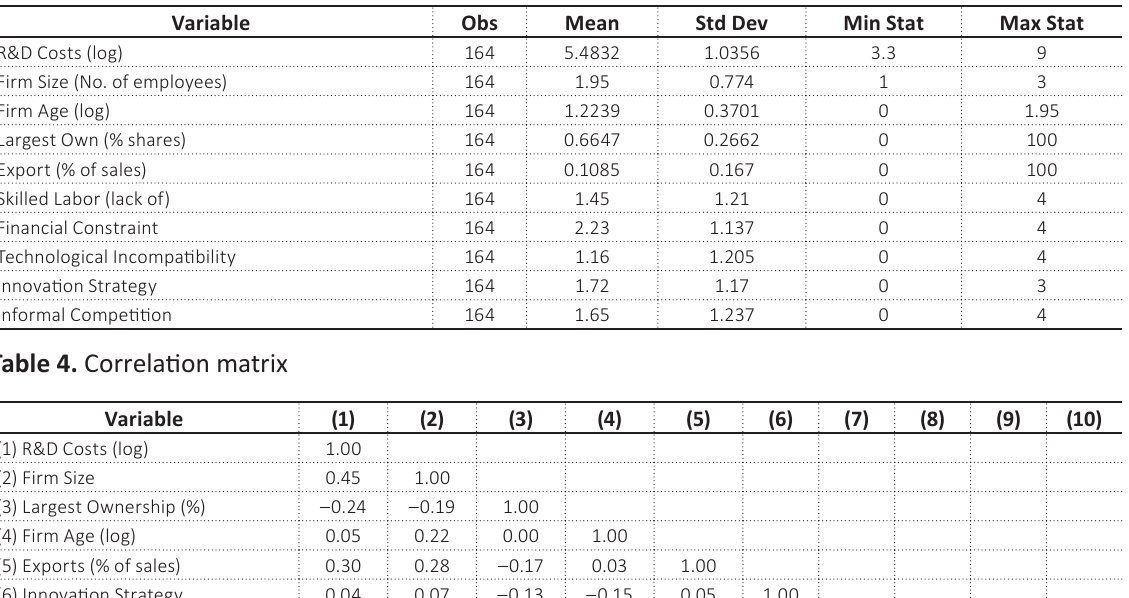
Table 3. Variable summary